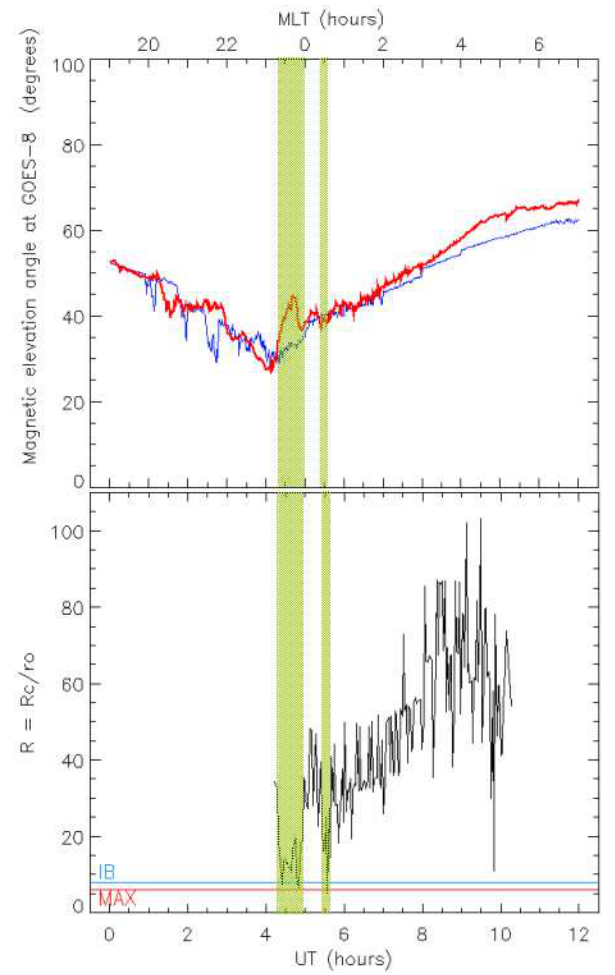
Figure 4 Fig. 4. The top panel shows an example of a 12-h period on 5 November 2000, where the magnetic elevation angle calculated by T01 at the GOES-8 position (blue line) is close to the GOES-8 mea- surements (red line). The panel below shows the R value calculated from the position of MAX-SI12 in the midnight sector at the same time. The grey areas show the regions where R is close to the ex- pected value ( R = 6 for the maximum, showed by the red